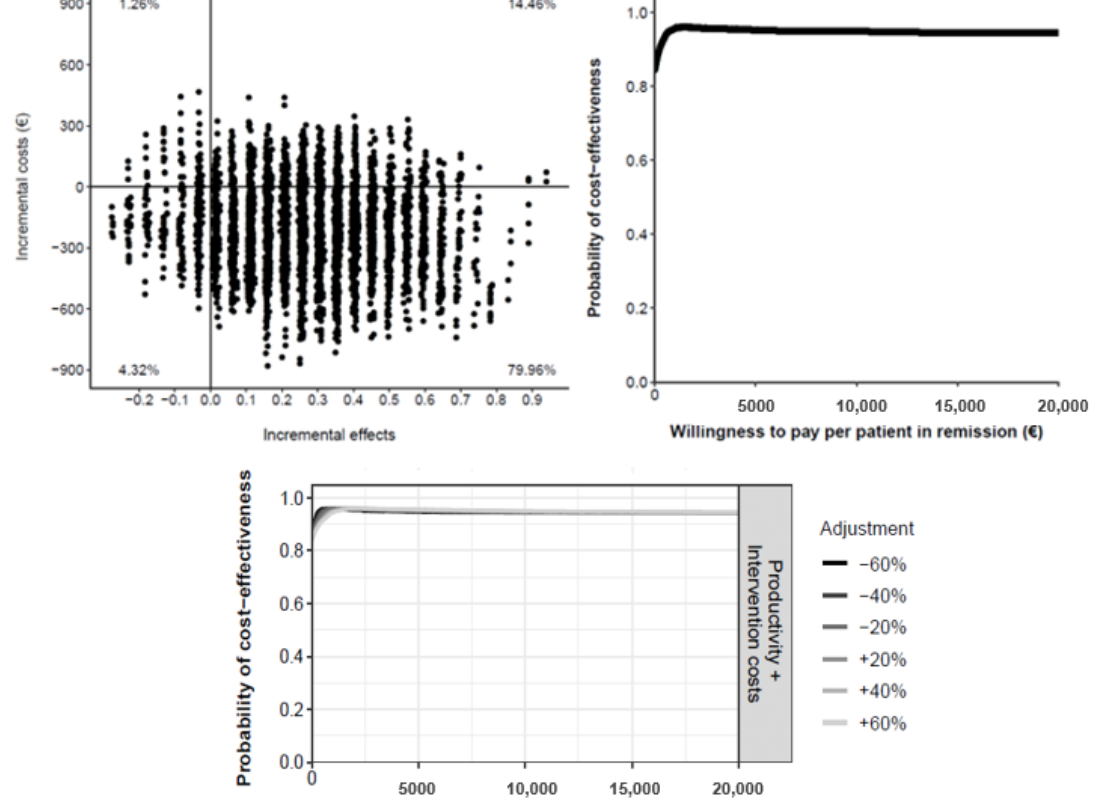
Figure 3. Cost-effectiveness plane (top left) and cost-effectiveness acceptability curve (top right) comparing the Telemonitoring of Crohn’s